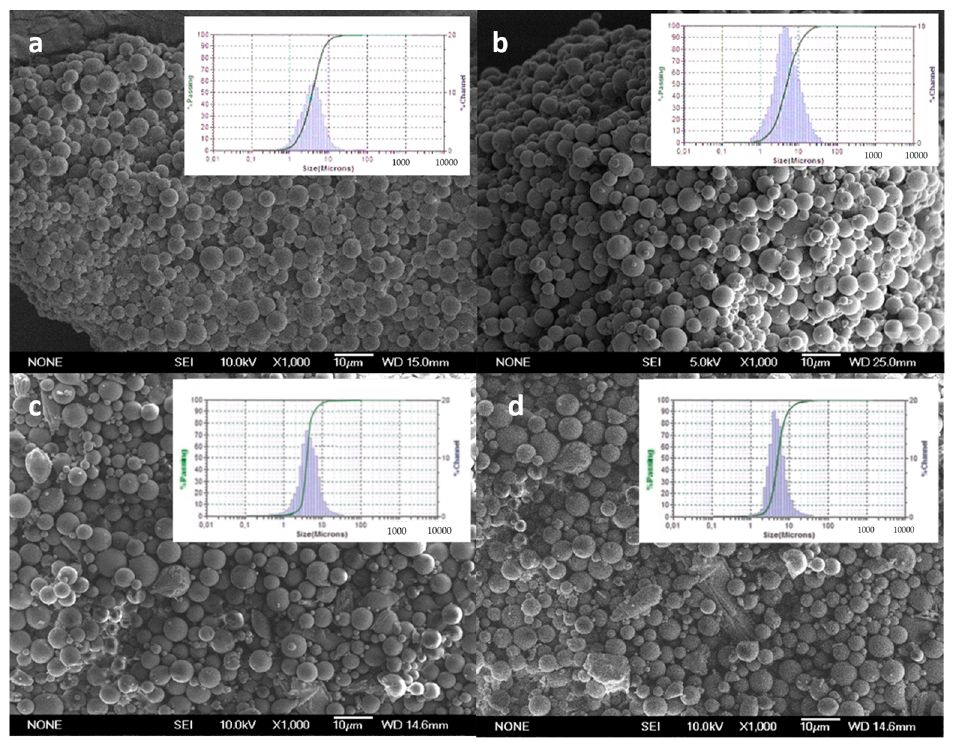
Figure 1. SEM microphotographs and particle size distributions of formulations. ( a ) MP-C1, ( b ) MP- C2, ( c ) MP-0 and ( d ) MP-F.